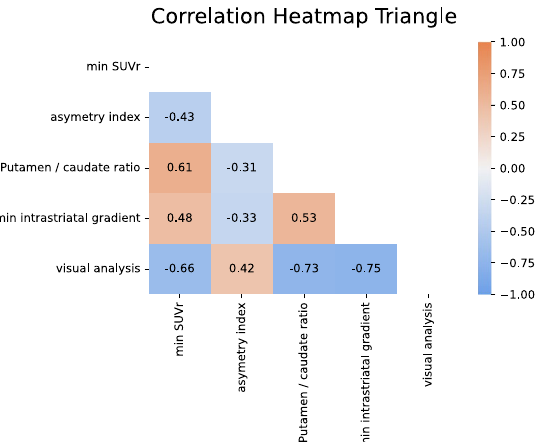
Fig. 6 Heatmap of the between PETmetrics correlations (Spearman rank test)